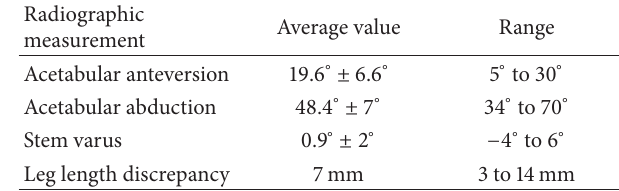
Table 3: Postoperative radiographic